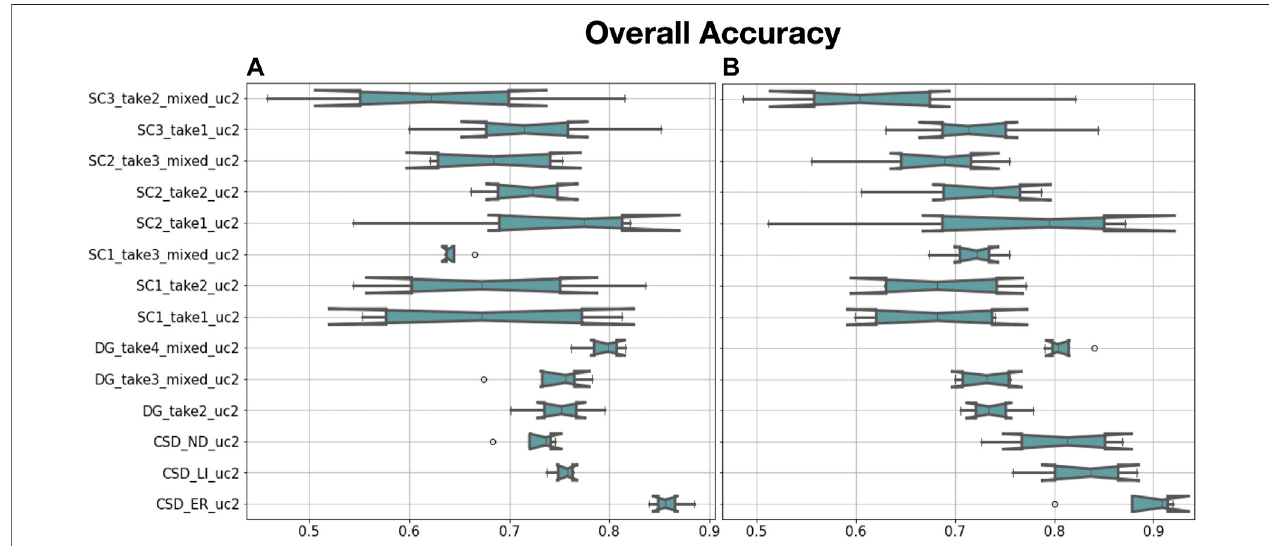
FIGURE6| Overallaccuracyobtained withCREPE onthe output ofOpen-Unmix. (A) Resultsfor Quartet case (model trained withone singerper part). (B) Results for Choir case(modeltrainedwithmultiplesingersperpart).SonglabelsbeginningwithSCandSGrefertosongsfromECDwhilesonglabelsbeginningwithCSDreferto songs from